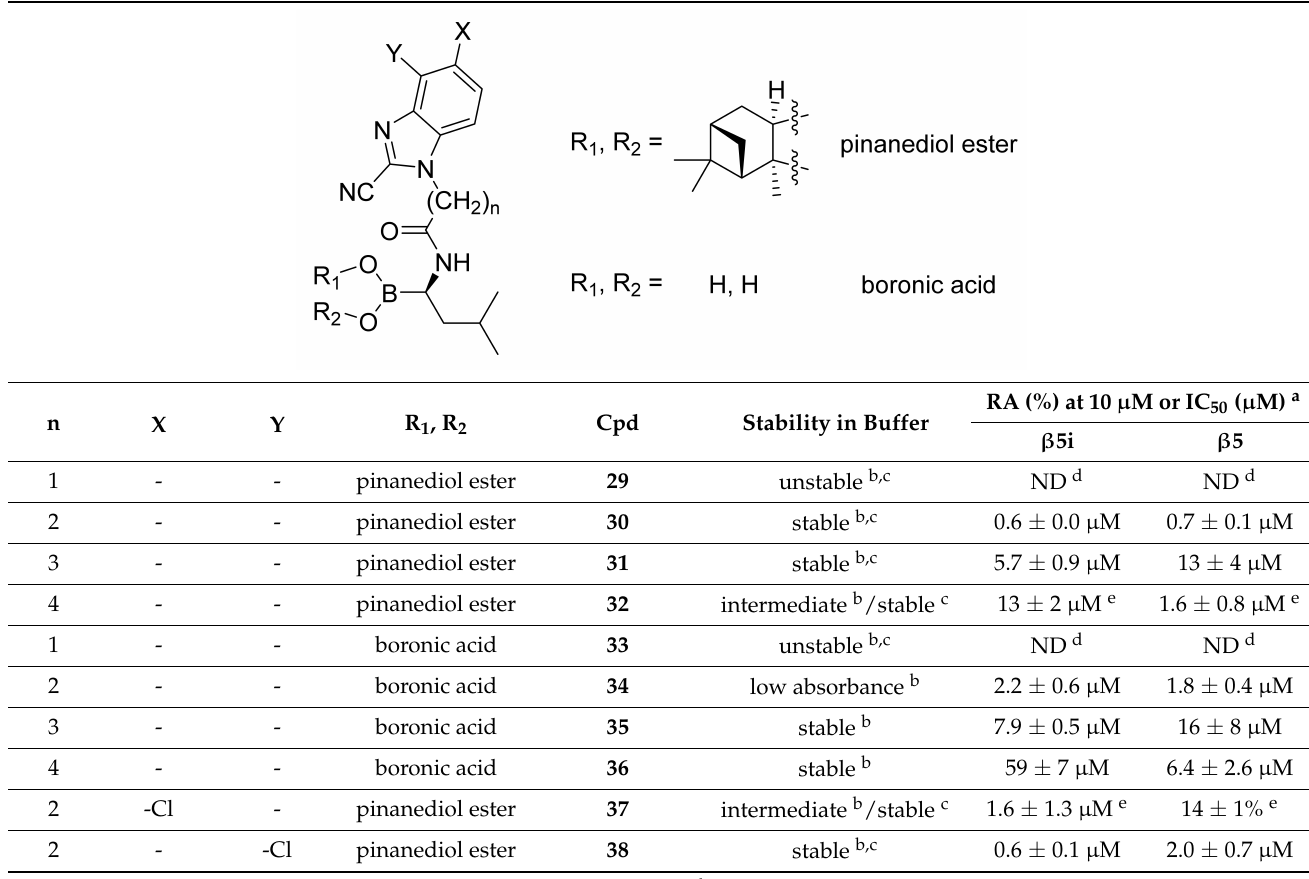
Table 4. Inhibitory potencies of benzimidazole-2-carbonitrile-containing boronic acid derivatives against the β 5i subunit of human iCP and the β 5 subunit of human cCP. The RA (for β 5i and β 5) values were determined at 10 µ M compound concentration and 30 min